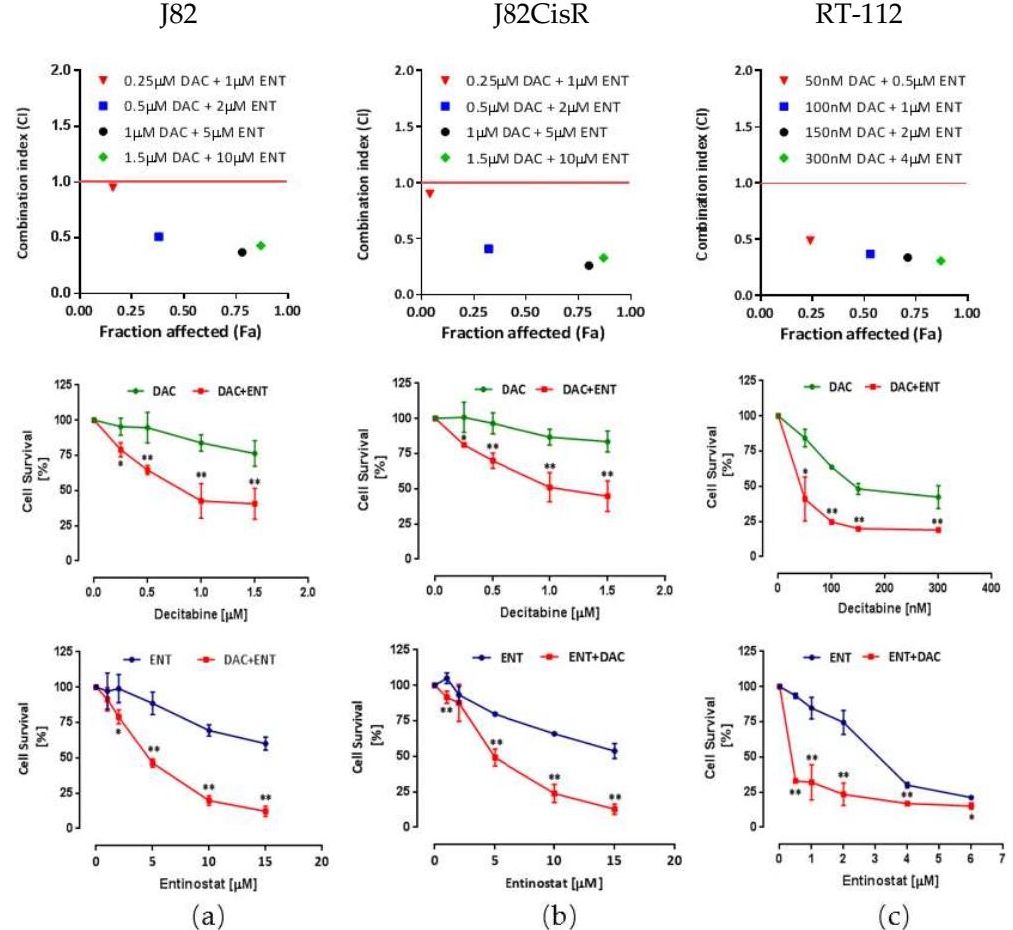
Figure 2. Combination of DAC and ENT elicits synergistic cytotoxic effects in urothelial bladder cancer cells. ( a ) J82; ( b ) J82CisR; ( c ) RT-112 cells. Upper panel: cells were treated for 48 h with DAC, followed by 72 h of ENT, respectively; x axis indicates fraction of cells affected (Fa); y axis indicates combination index (CI). Synergistic effect is defined by a CI below the red line (CI < 1). Middle and bottom panels: percentage of cell survival after treatment with DAC or ENT alone or in combination. Data shown are the mean ± SD of at least three independent experiments. ** p < 0.01, * p < 0.05, t -test, combination treatment compared with single treatments.